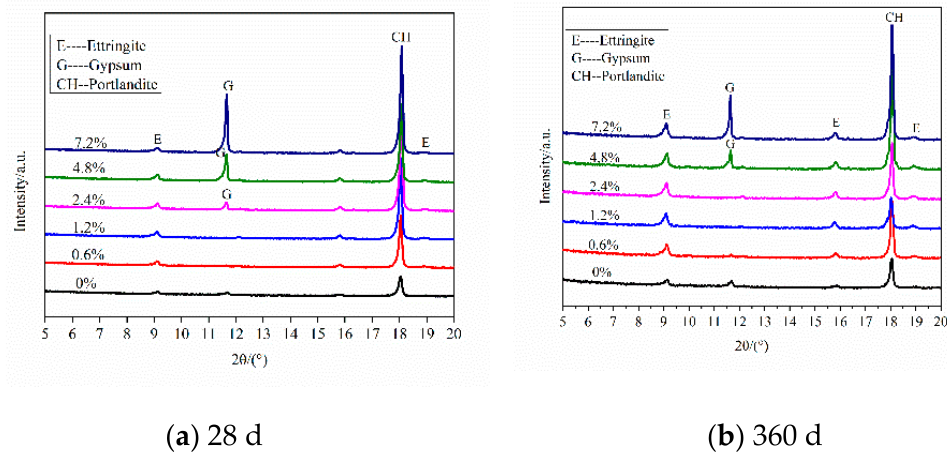
Figure 5. XRD patterns of mortars with different SO 3 content in aggregate.